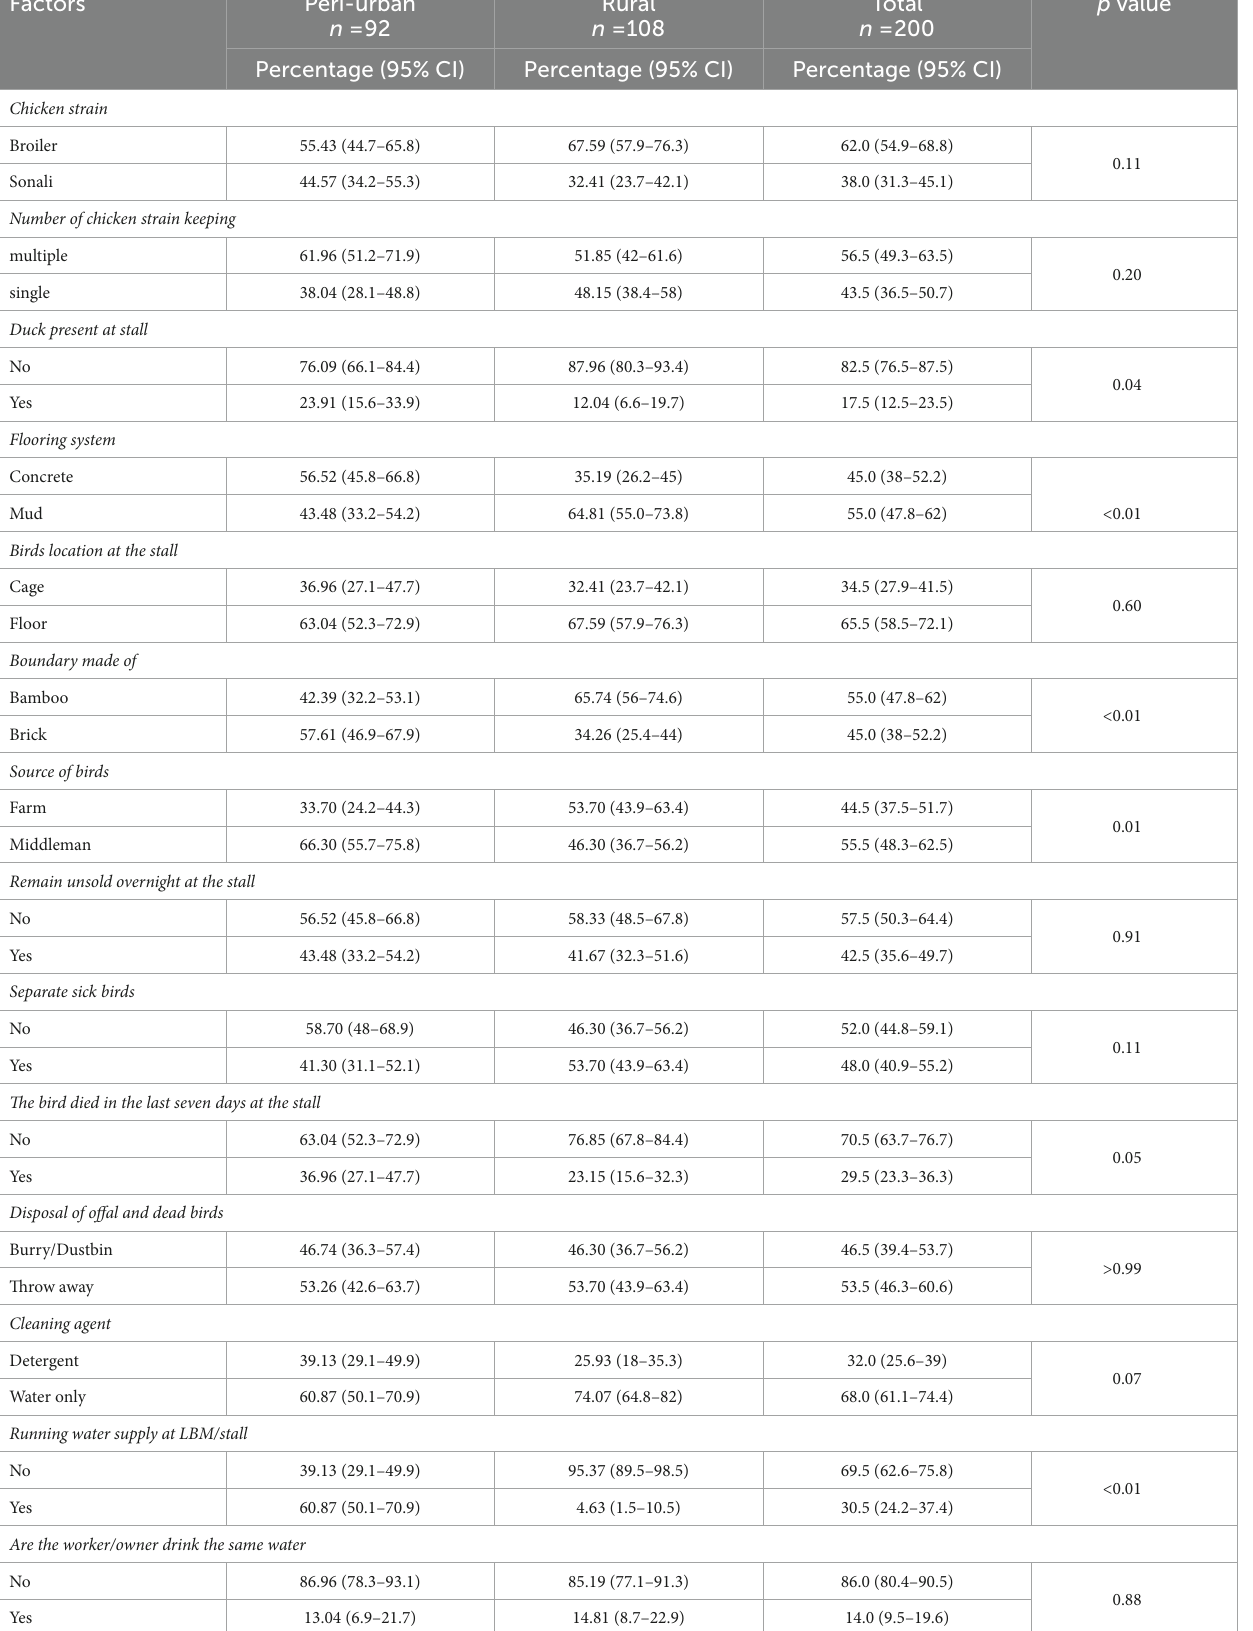
TABLE 1 Frequency of physiographic and hygienic status of the studied poultry markets in peri-urban and rural LBMs.